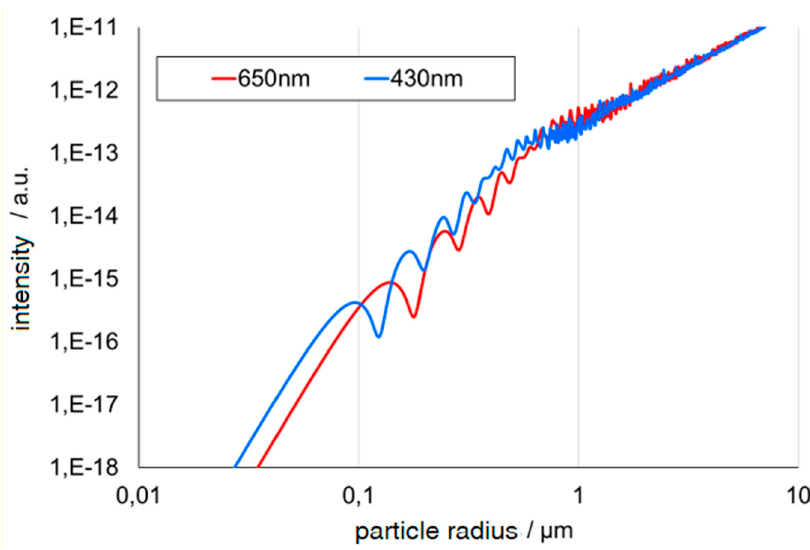
Figure 4. Oscillating intensity from two wavelengths [4].